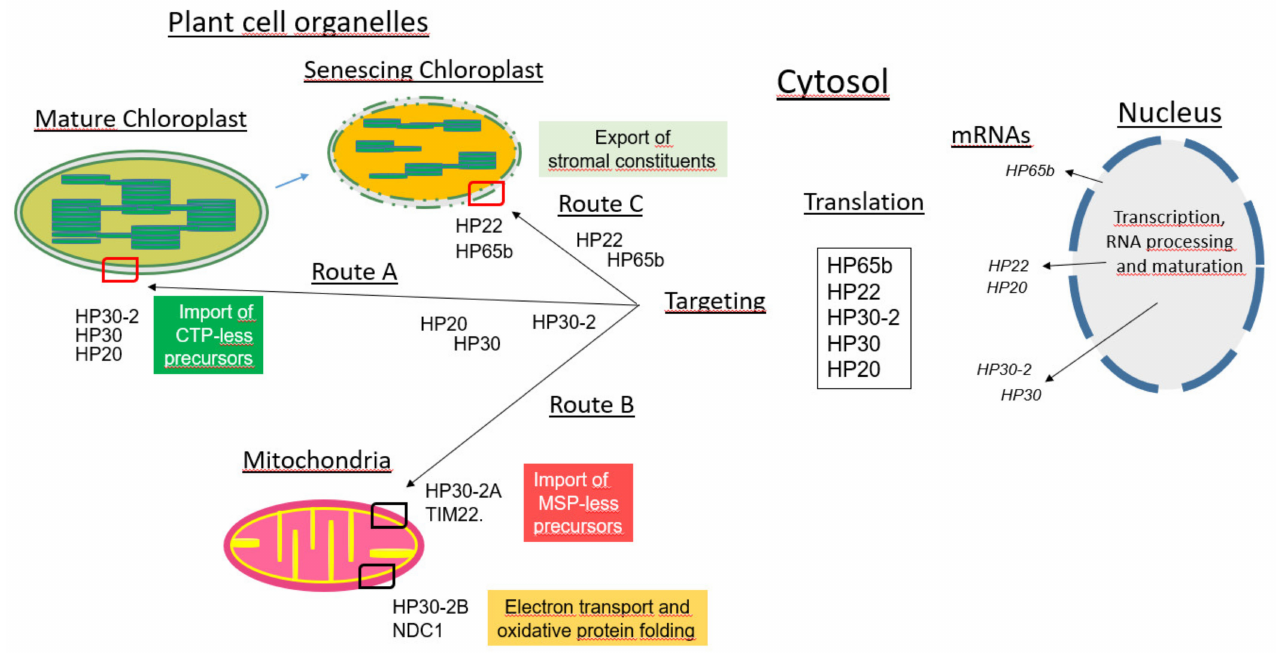
Figure 8. Cartoon summarizing the role of the different PRAT proteins analyzed in vivo . HP20, HP22, HP30 and HP30-2 are PRAT proteins that are all encoded in the nucleus. Their genes transcribed depending on developmental and environmental factors. The resulting transcripts undergo processing and modifications and are then transported into the cytosol where they bind to 80 ribosomes and are translated into protein. In turn, HP20, HP22, HP30 and HP30-2 are targeted to different destinations, all four being transported to chloroplasts, whereas a fraction of HP30-2 is dually targeted and thus is also transported to mitochondria. Chloroplast HP20, HP30 and HP30-2 establish a unique protein translocase for the import of chloroplast transit peptide (CTP)-less precursors. Similarly, mitochondrial HP30-2 operates in the import of mitochondrial signal peptide (MSP)-less precursors, while interacting with TIM22 and other components. By contrast, HP22 appears to play a specific role in senescing chloroplasts where it interacts with HP65 and thereby controls the export of stromal proteins to the cytosol. Note that the sizes of the nucleus and different plant cell organelles is not drawn to